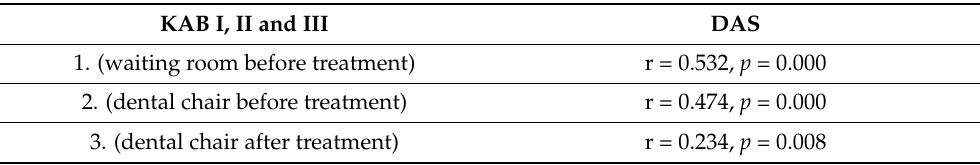
Table 1. Correlations (Pearson) between dental anxiety (DAS) and the values of KAB total scores I, II and III (waiting room, dental chair before treatment and dental chair after